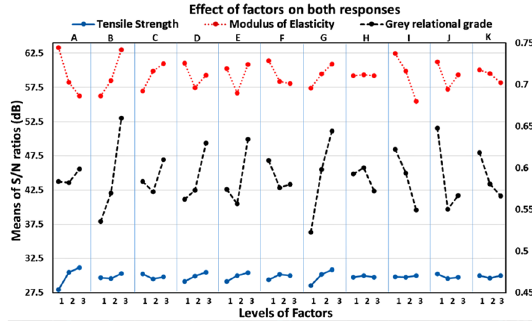
Figure 3 Graphical representation of effects of parameters on UTS, modulus of elasticity, and grey relational